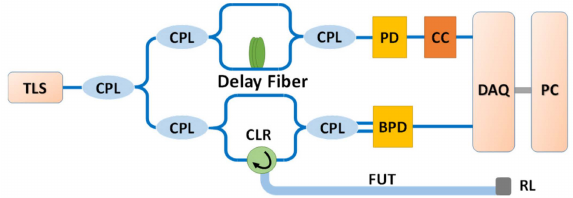
Figure 3. Optical frequency-domain reflectometry (OFDR) system. The auxiliary interferometer is an unbalanced Mach–Zehnder interferometer with a 250-m reference delay fiber. TLS: tunable laser source; CPL: fiber couple; CLR: fiber circular; PD: photo detector; BPD: balanced photo detector; CC: clock circuit; DAQ: data acquisition card; PC: personal computer; FUT: fiber under test; RL: refractive index matching